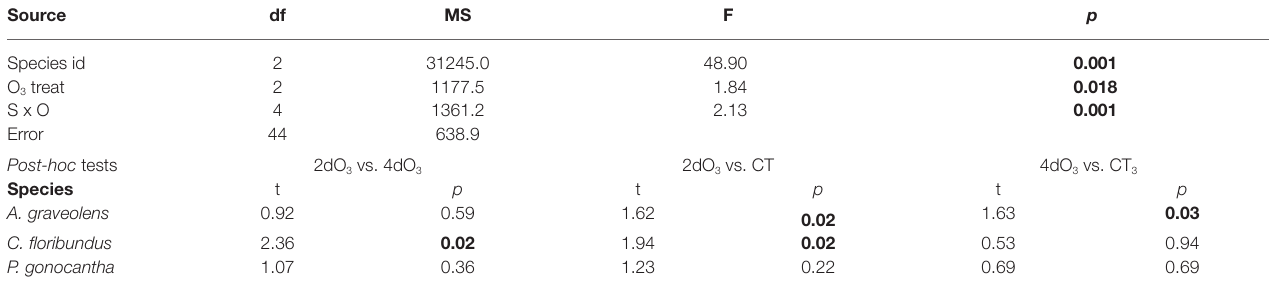
TABLE 1 | Summary results of PERMANOVA and post-hoc tests for BVOC profile considering the effects of species identity and O 3 treatment.